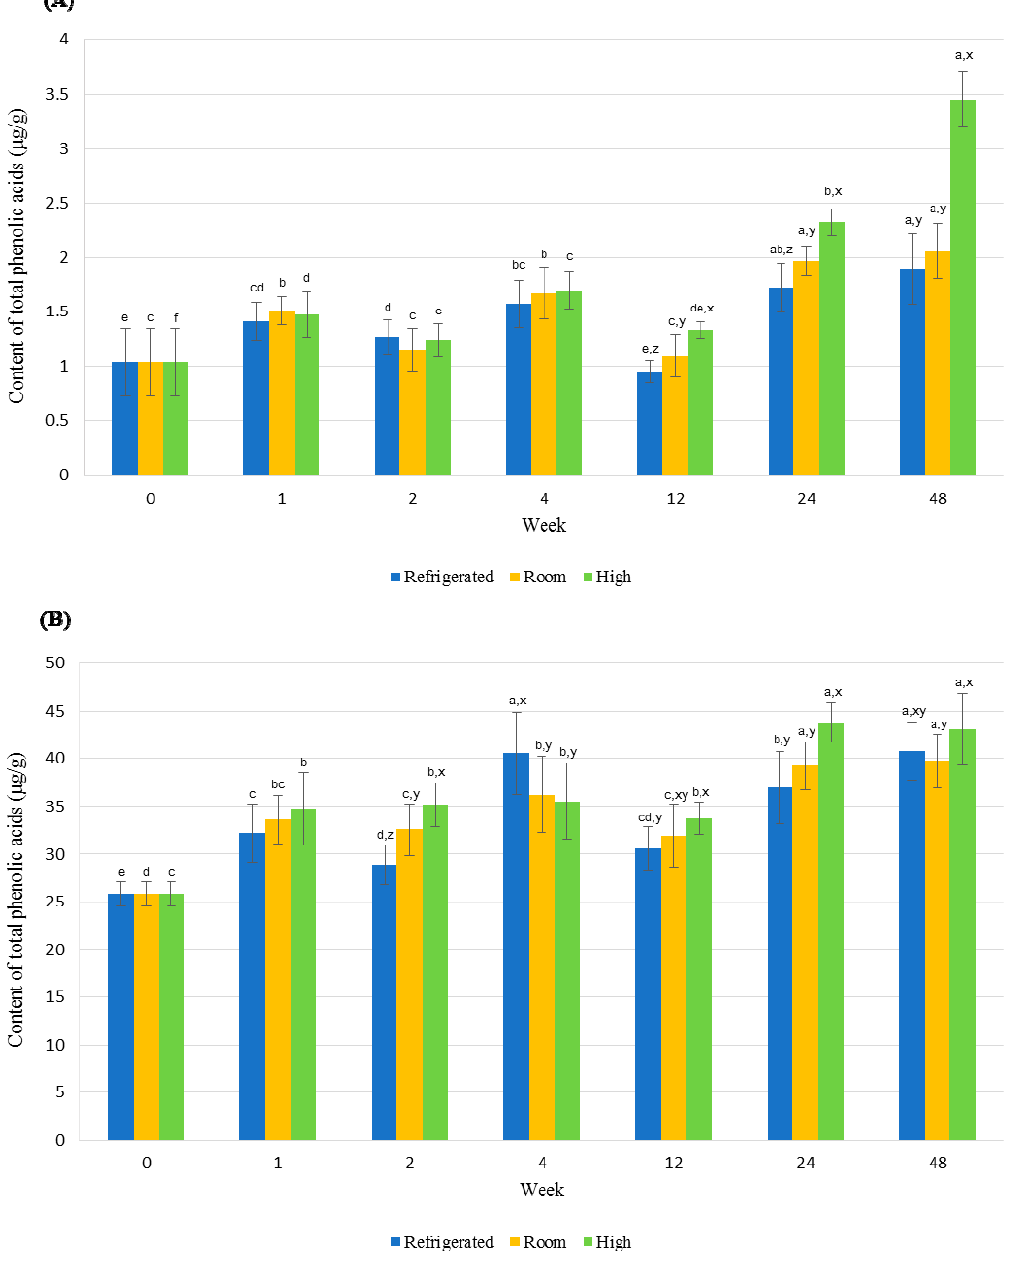
Figure 7. Comparison of the total phenolic acids in ( A ) RWSF and ( B ) RSF according to storage time and temperature. The blue, yellow, and green-colored bars indicate 4, 20 and 45 °C temperature, respectively. a–f Values with different statistically different superscripts depending on storage time (control, after 1, 2, 4, 12, 24, and 48 weeks) ( p < 0.05). x–z Values with different statistically different superscripts between storage temperature (RFT, RT, and HT) ( p < 0.05).